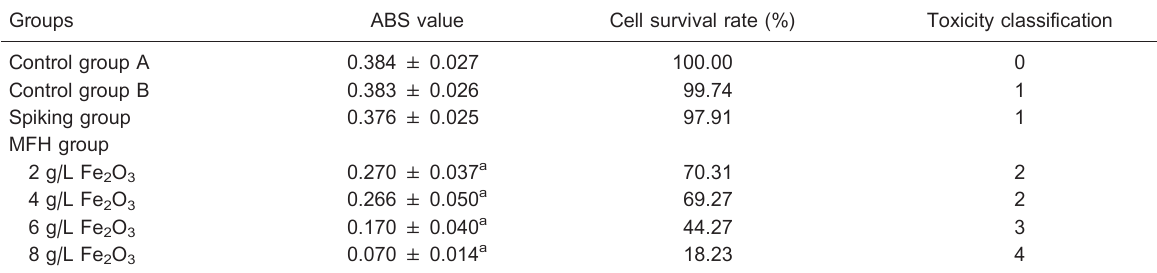
Table 2. MTT results of SMMC-7721 cells after MFH using Fe 2 O 3 nanoparticles. Groups